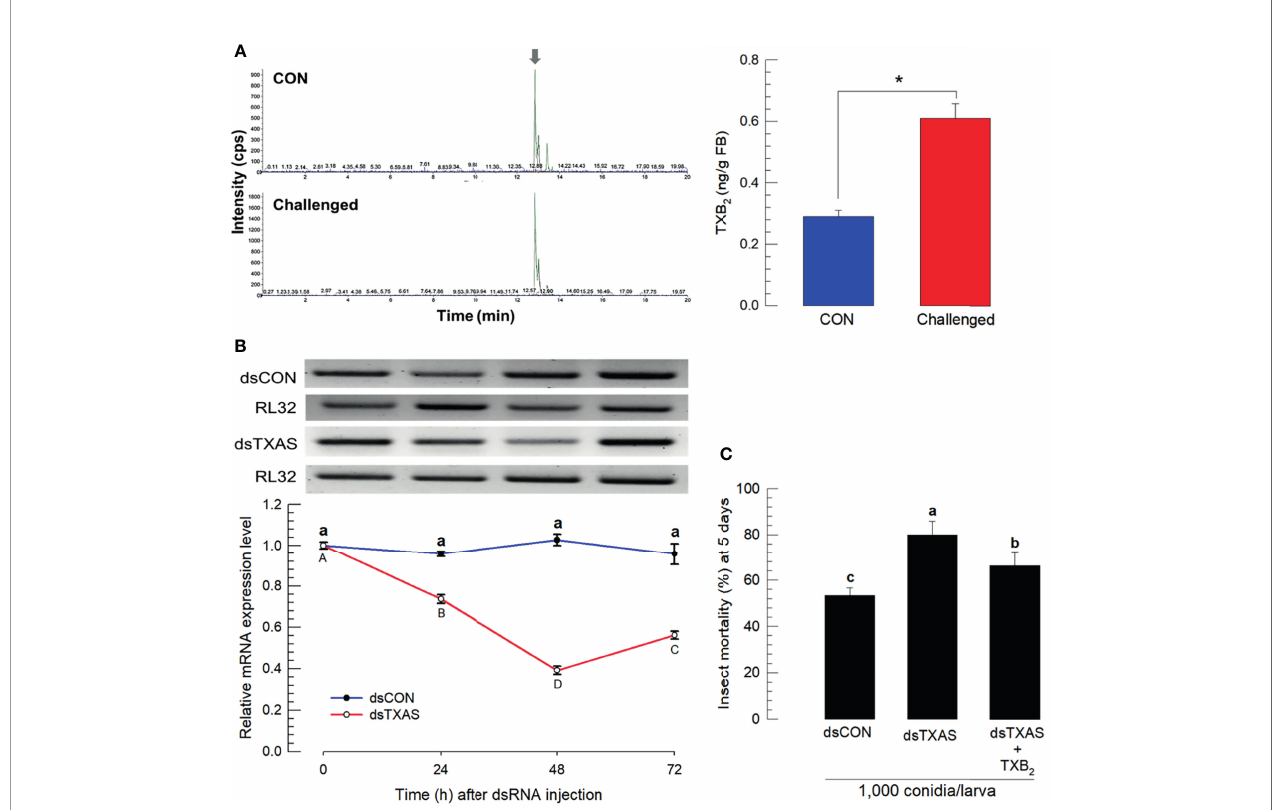
FIGURE 5 | Mass spectral determination of TXB 2 and in fl uence of silencing SeTXAS on mortality. Panel (A) shows that the fungal challenge led to increased concentrations of larval fat body TXB 2 at 16 h PFI. An arrow shows TXB2 peaks on LC-MS chromatograms Panel (B) shows the in fl uence of injecting an RNAi construct designed to SeTXAS on accumulations of SeTXAS mRNAs. Control dsRNA ( ‘ dsCON ’ ) used dsRNA speci fi c to GFP . Panel (C) shows the in fl uence of dsTXAS on L4 larval mortality at 5 days PFI. Each treatment was replicated three times. Data analyzed and presented as described in Methods . Different letters or asterisks above standard deviation bars indicate signi fi cant difference among means at Type I error = 0.05 (LSD